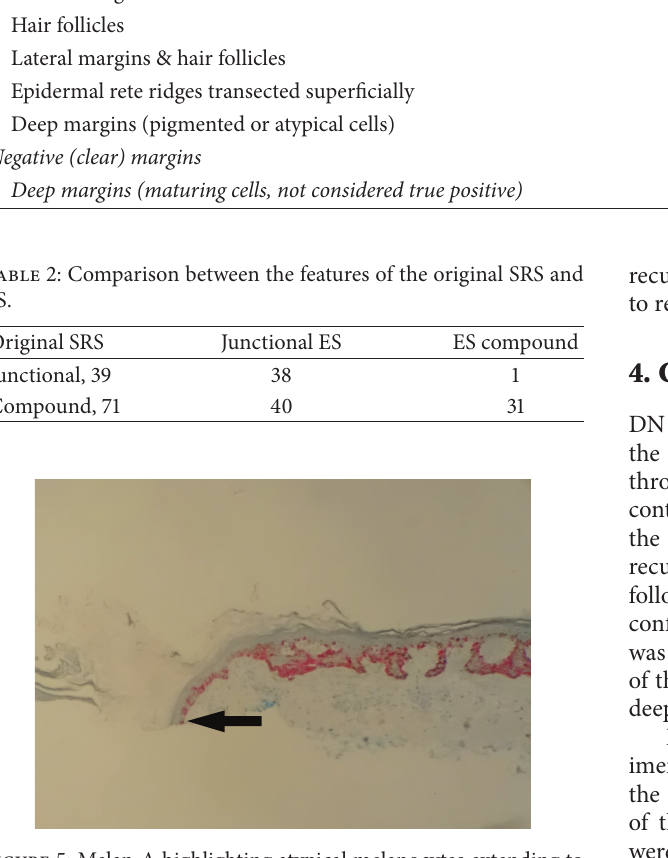
Figure 5: Melan-A highlighting atypical melanocytes extending to the hair follicle at the deep margin, not identifiable by the H&E stain in Figure 4 (arrow) (Melan A;